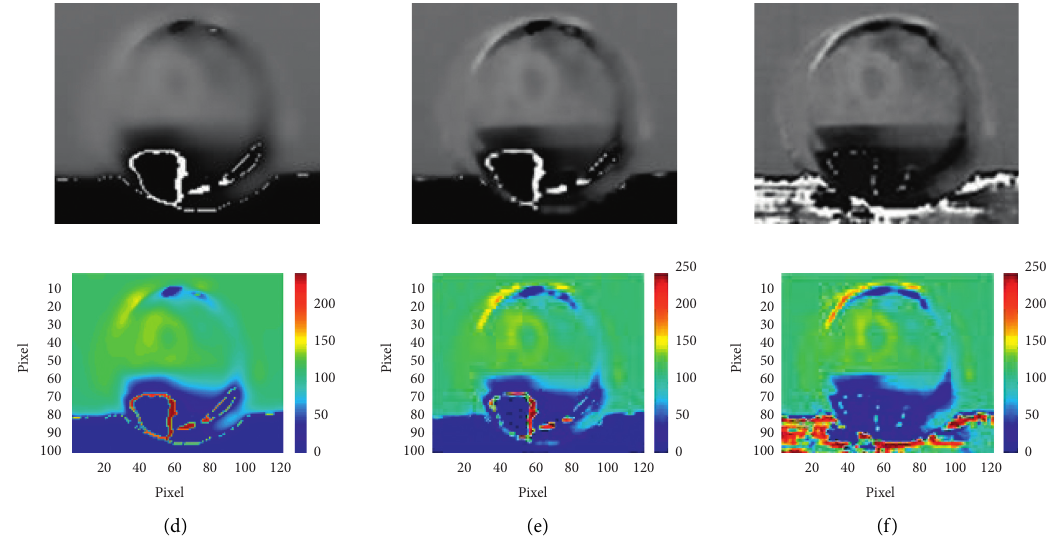
Figure 11: The corresponding error distribution map of hole patching. (a) Original depth map. (b) Median filtering method. (c) Gaussian filtering method. (d) Bilateral filtering method. (e) Joint bilateral filtering method. (f) Convolutional neural network